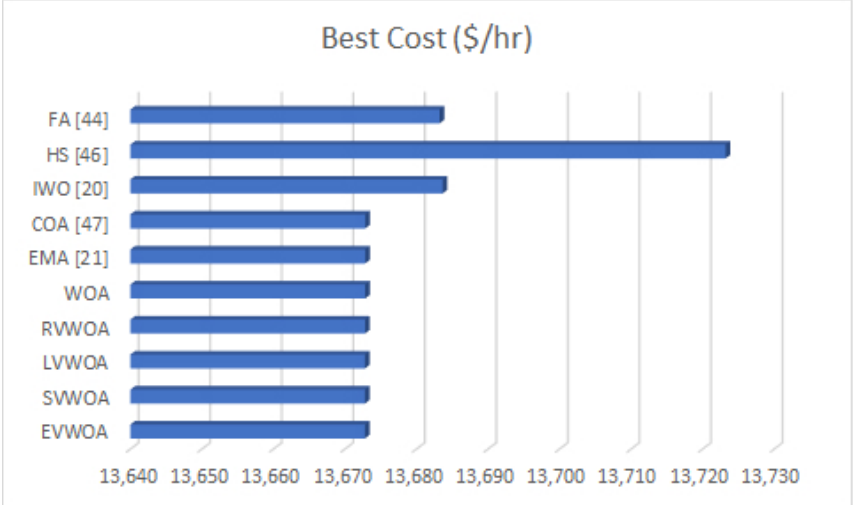
Figure 10. Best Cost Comparison for Case Study 2.